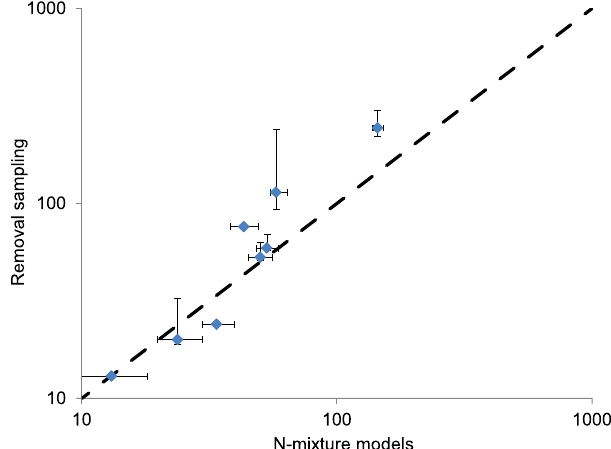
Figure 2. Abundance of H. ambrosii : comparison between removal sampling and N -mixture models. Error bars are 95% confidence intervals of each estimate, the black dashed line has intercept = zero and slope = 1.